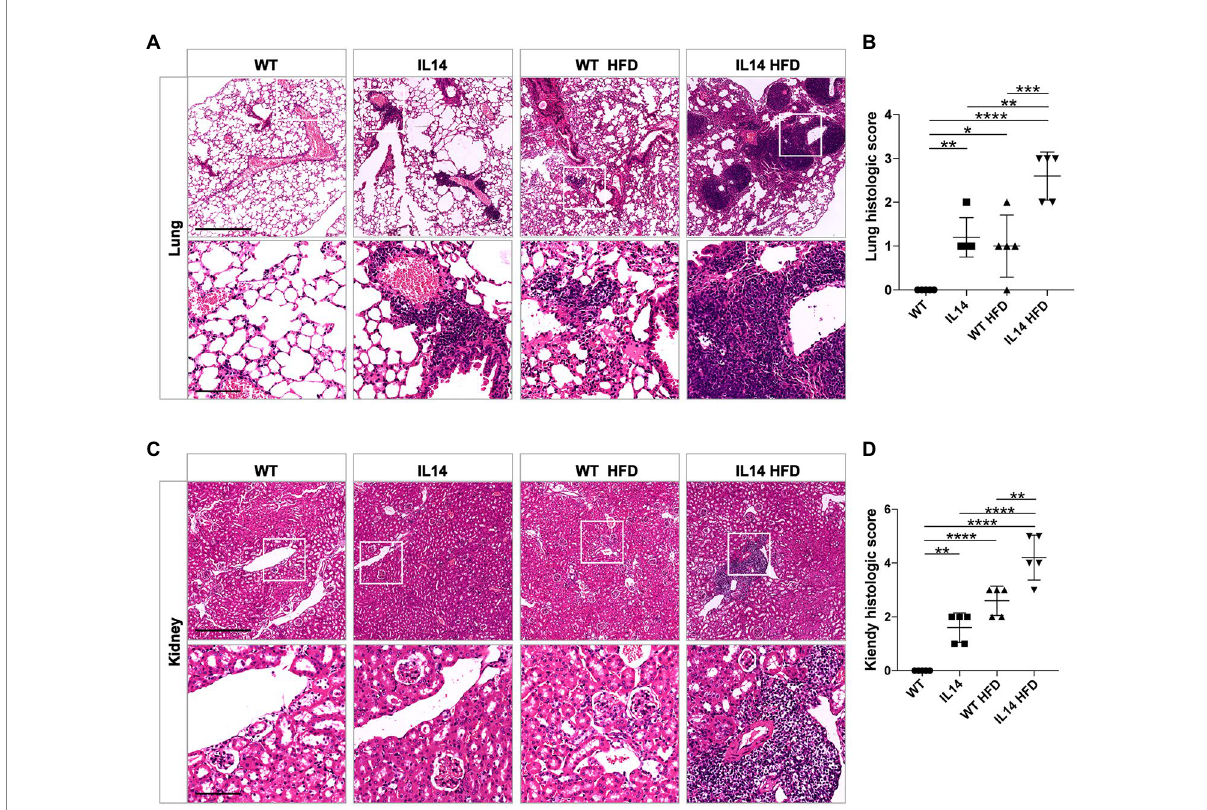
FIGURE 4 HFD exacerbated lung and kidney injury in the IL-14 α TG mice. Lung and kidney tissues from the WT, IL14, WT HFD, and IL14 HFD groups were isolated for analysis. Lung (A) and kidney (C) sections were stained with H&E, and representative images are shown. (B,D) A histologic score of the lungs and the kidneys was quantified as described in the section “Materials and Methods,” showing worse tissue damage and an increase in infiltration in the IL14 HFD group. * p ≤ 0.05; ** p ≤ 0.01; *** p ≤ 0.005; and **** p ≤ 0.001; n = 5 per group. Scale bars: 500 μ m for H&E staining, 100 μ m for enlarged